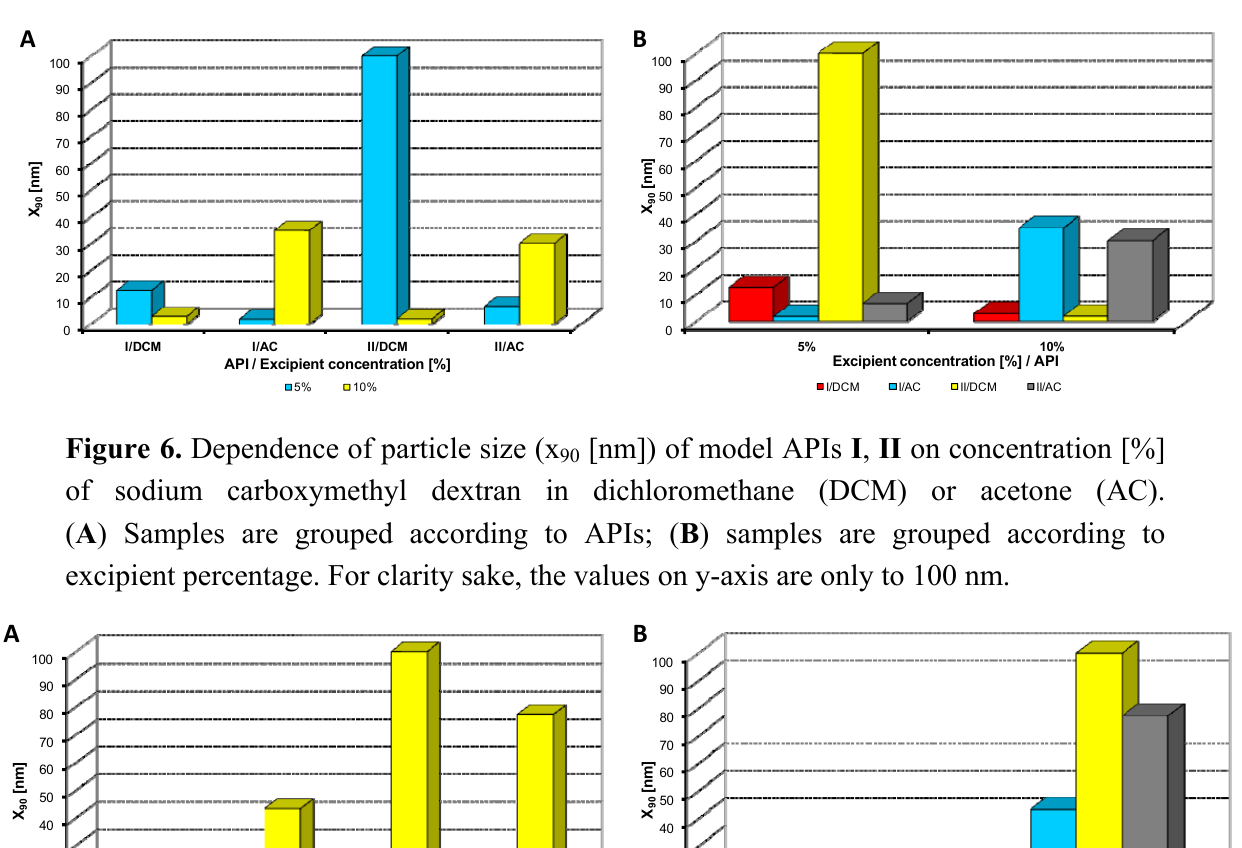
Figure 5. Dependence of particle size (x [nm]) of model APIs I , II on concentration [%] 90 of sodium carboxymethyl cellulose in dichloromethane (DCM) or acetone (AC). ( A ) Samples are grouped according to APIs; ( B ) samples are grouped according to excipient percentage. For clarity sake, the values on y-axis are only to 100 nm.